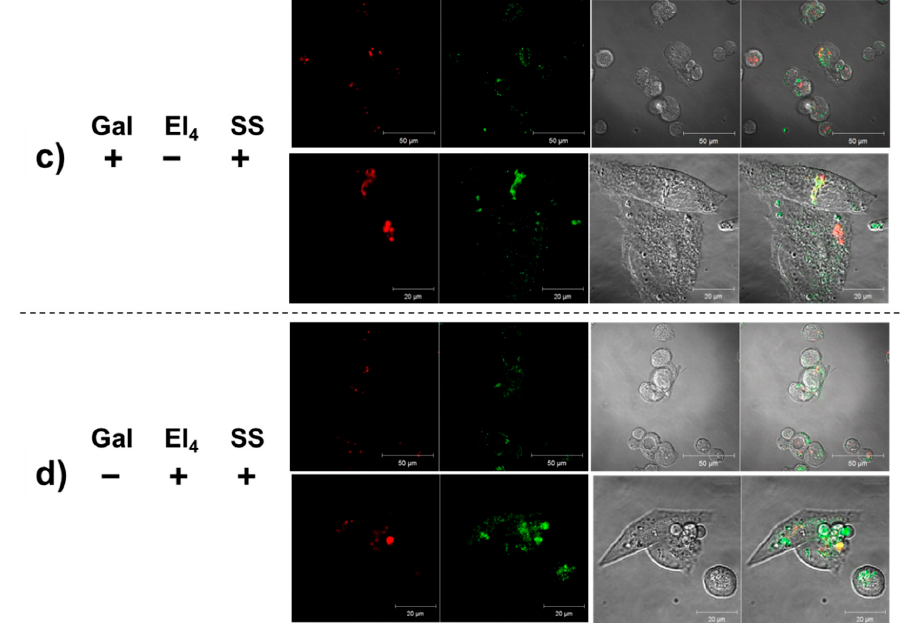
Figure 8. CLSM images of HepG2 cells with various FITC-labeled nanogels and LysoTracker RED after 5 h incubation at 37 °C. ( a ) EI 4 /Gal-Dex- g -SS-OLA, ( b ) EI 4 /Gal-Dex- g -OLA, ( c ) Gal-Dex- g -SS-OLA, and ( d ) EI 4 -Dex- g -SS-OLA. Scale bar: 50 µm (top row of each panel) and 20 µm (bottom row of each panel).